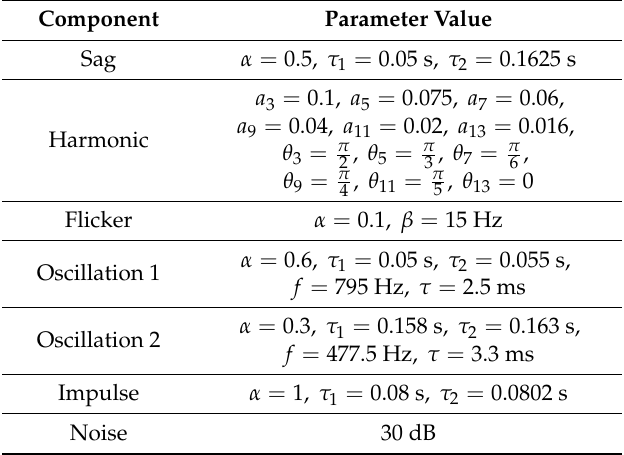
Table 3. The parameters of the test